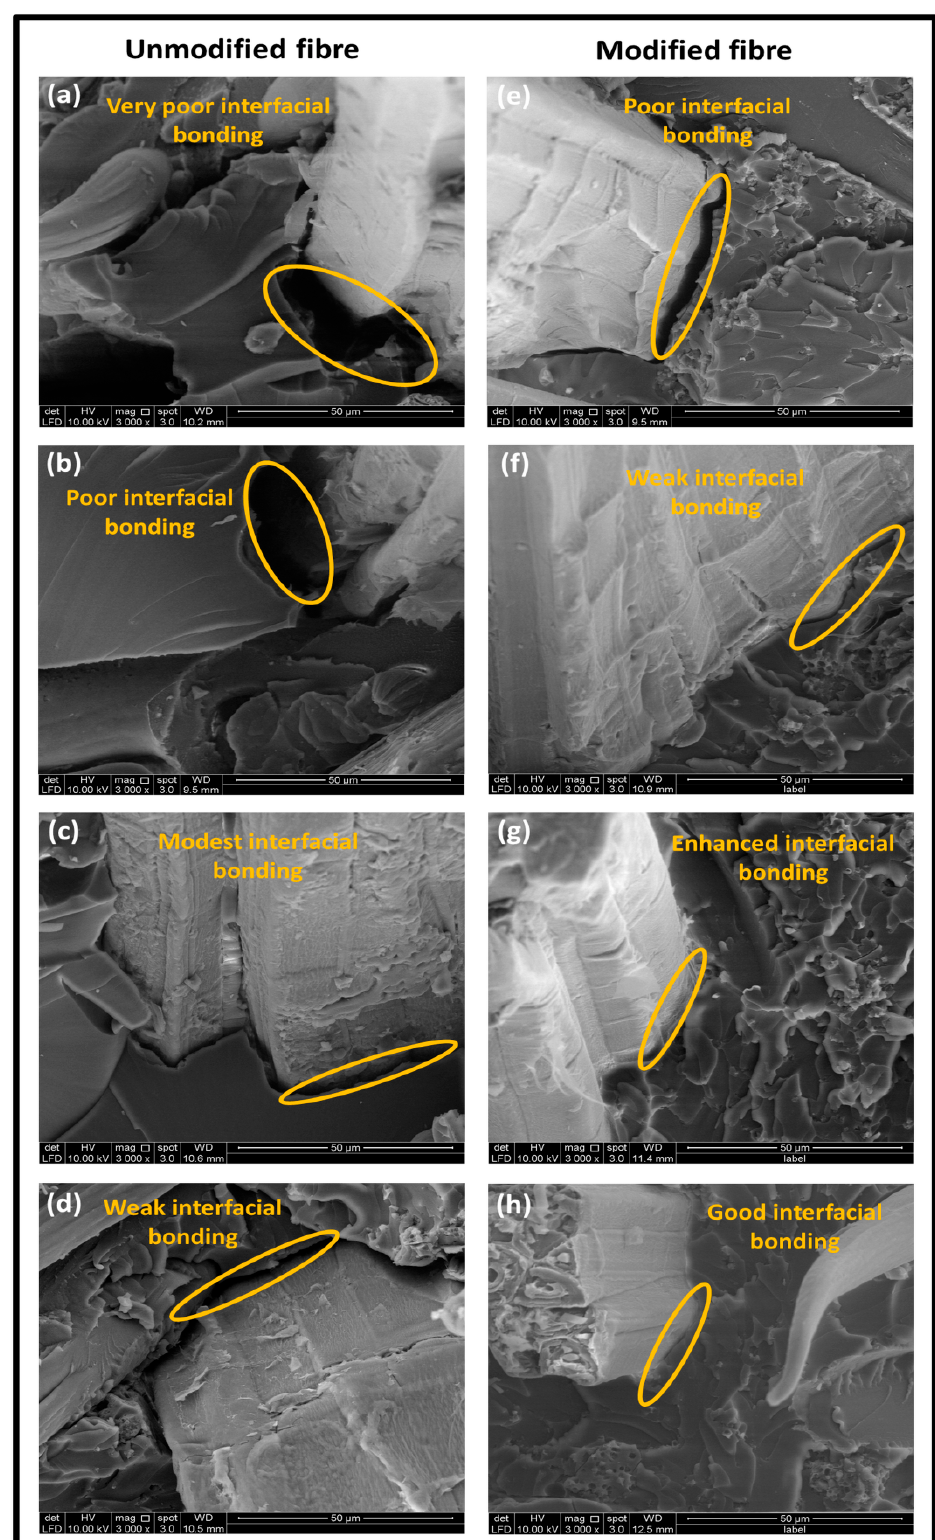
Figure 8. FESEM micrograph of tensile fracture sample of ( a ) VE/UK/NC0 ( b ) VE/UK/NC1 ( c ) VE/UK/NC3 ( d ) VE/UK/NC5 ( e ) VE/MK/NC0 ( f ) VE/MK/NC1 ( g ) VE/MK/NC3 and ( h ) VE/MK/NC5.